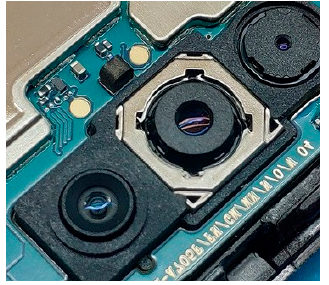
Figure 8. The photographic tool.